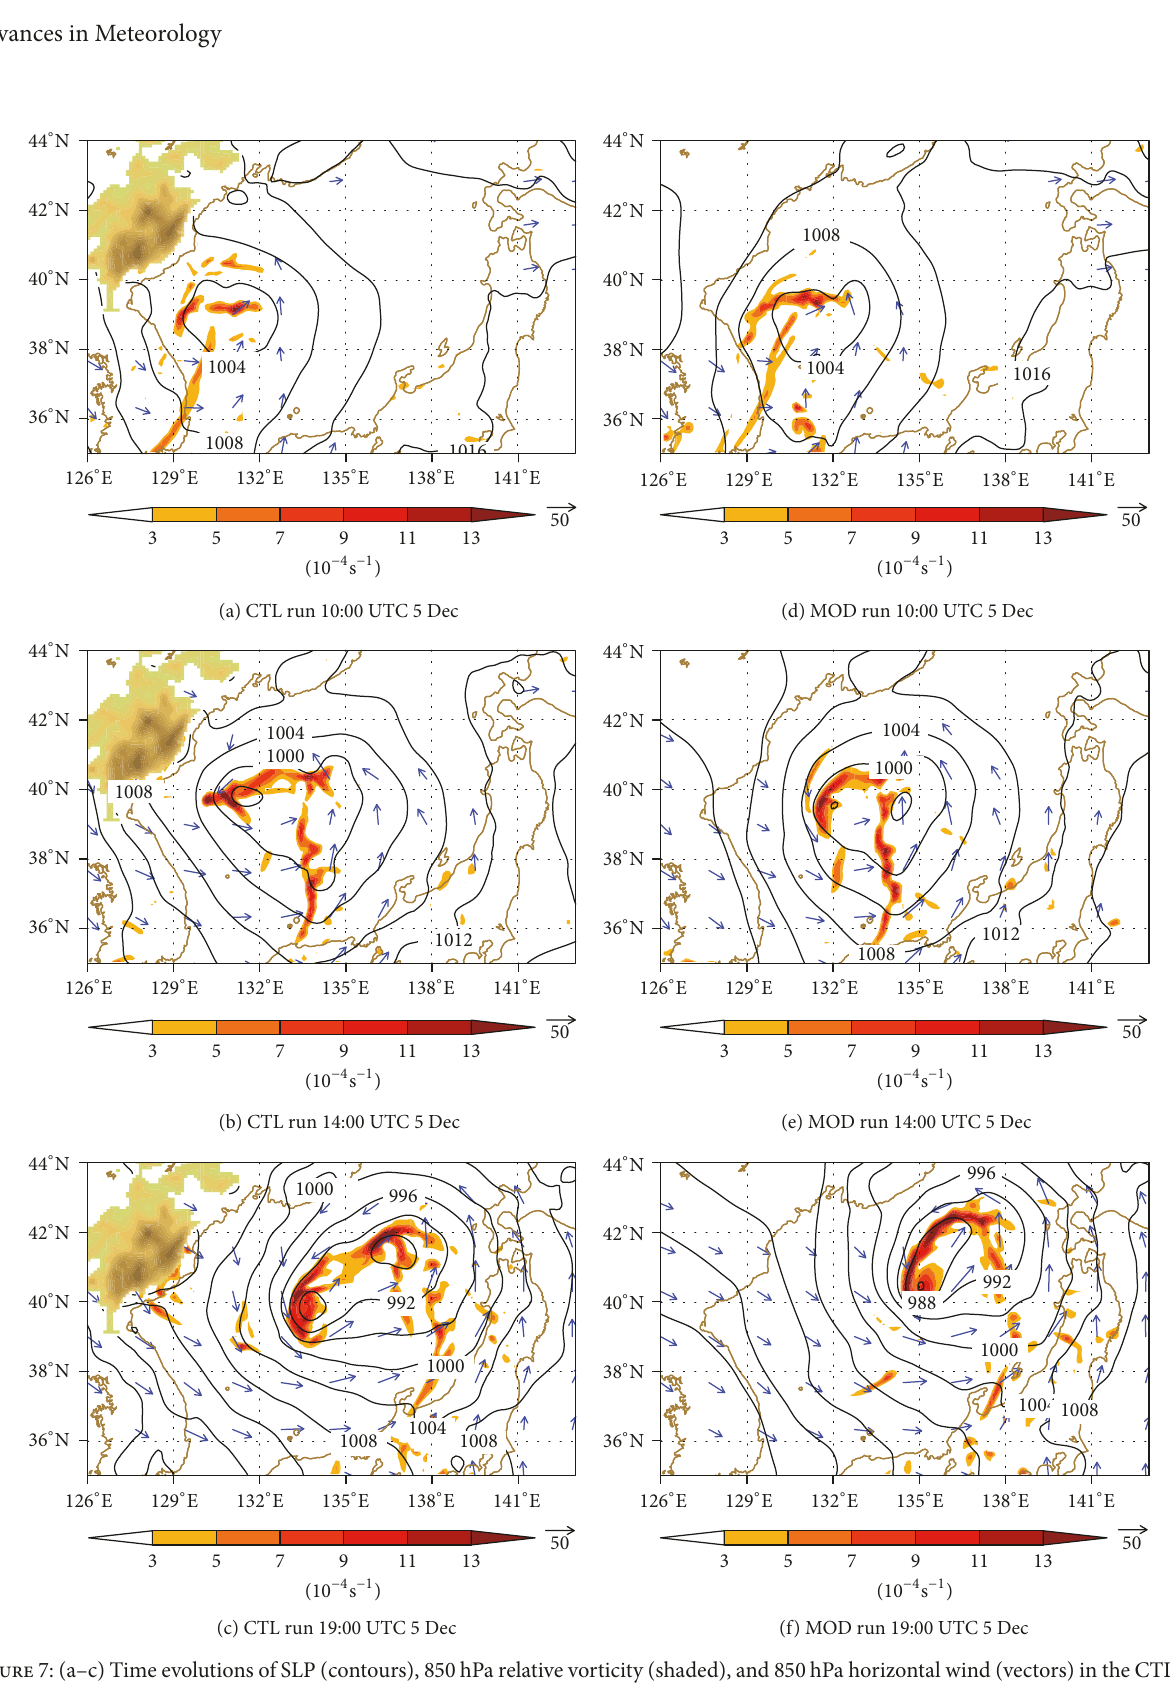
Figure 7: (a–c) Time evolutions of SLP (contours), 850 hPa relative vorticity (shaded), and 850 hPa horizontal wind (vectors) in the CTL run for case 1. The contoured interval is 4 hPa. The shading interval is 2 × 10 −4 s −1 . The reference arrow is 50m s −1 . Wind speeds less than 15m s −1 are suppressed. (d–f) As in (a–c) but for the MOD